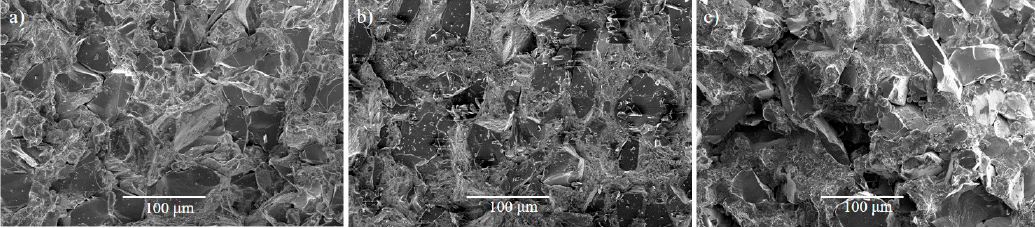
Figure 4. SEM images of fracture surface of composites tested at room temperature and manufactured at: ( a ) 900 °C; ( b ) 1000 °C; and ( c ) 1000 °C with Ti-Al.